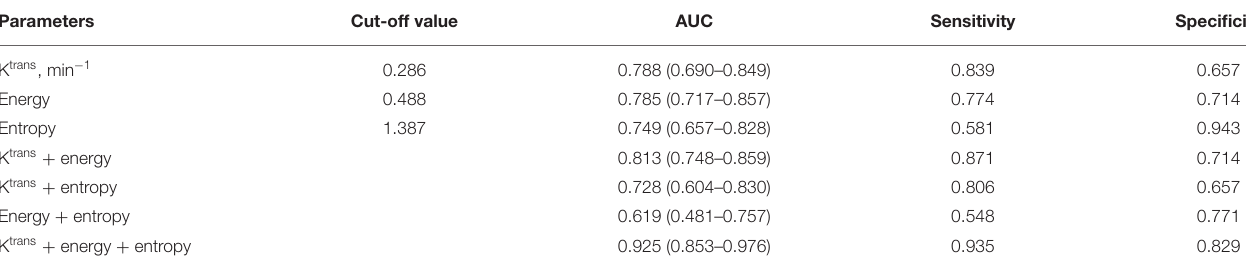
TABLE 2 | Diagnostic efficiency of each parameter and their combined metrics. Parameters